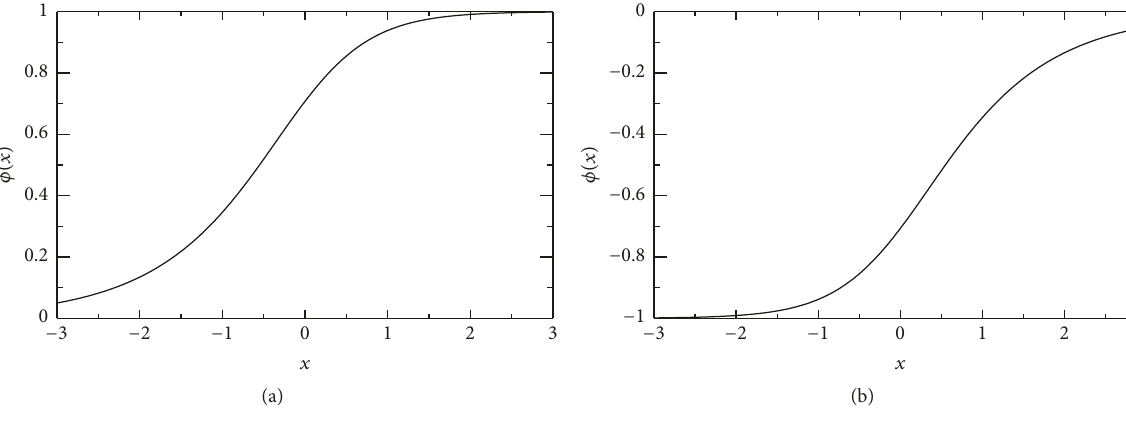
and thus one-loop order ( ℏ = 1 for the units used